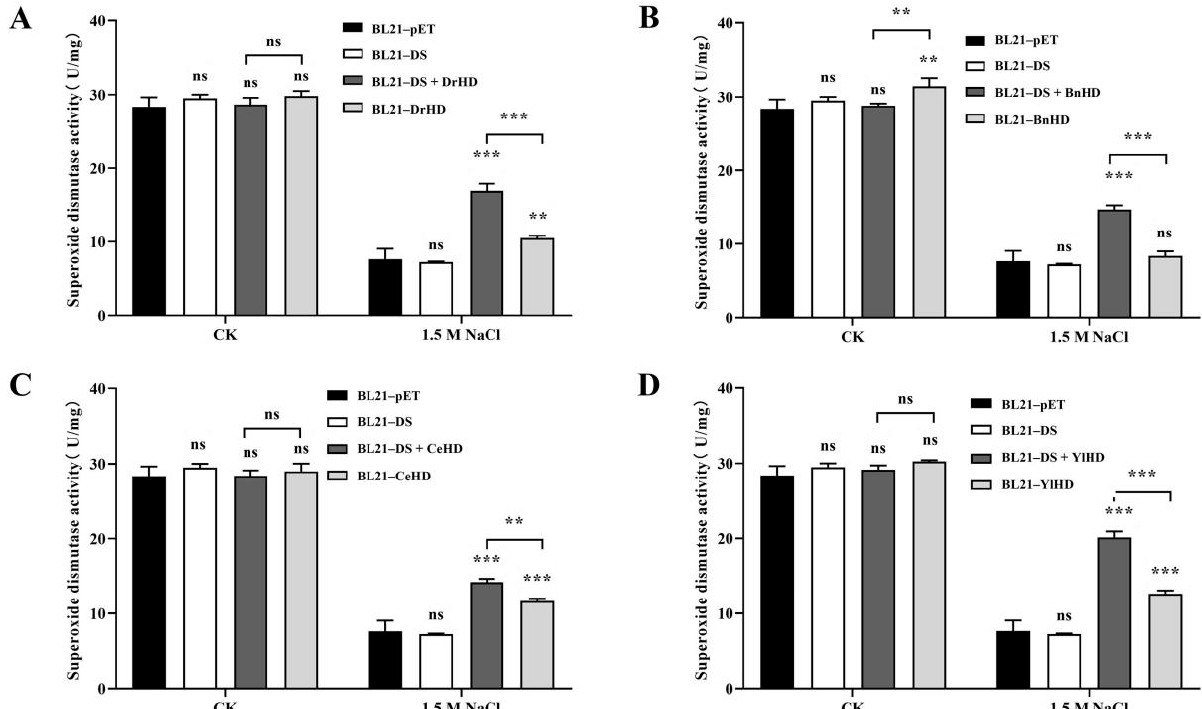
Figure 4. Superoxide dismutase activity analysis. ( A ) Analysis of superoxide dismutase activity of recombinant strains BL21-DS + DrHD and BL21-DrHD. ( B ) Analysis of superoxide dismutase activity of recombinant strains BL21-DS + BnHD and BL21-BnHD. ( C ) Analysis of superoxide dismutase activity of recombinant strains BL21-DS + CeHD and BL21-CeHD. ( D ) Analysis of superoxide dismutase activity of recombinant strains BL21-DS + YlHD and BL21-YlHD. The symbols ‘ns’, ‘**’ and ‘***’, respectively, represent ‘no significantly different ( p > 0.05)’, ‘a significant difference (0.01 < p < 0.05)’, ‘an extremely significant difference (0.001 < p < 0.01)’, and ‘the most significant difference ( p < 0.001)’.